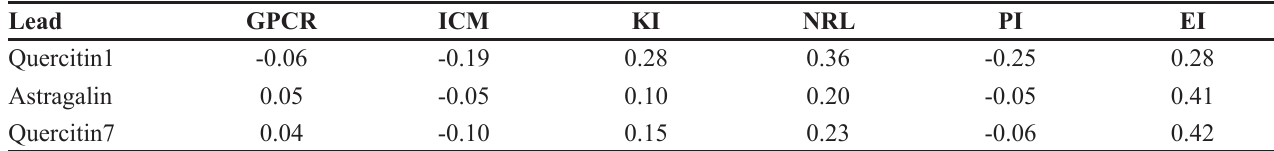
TABLE II - Estimation of drug ability of the three lead compounds